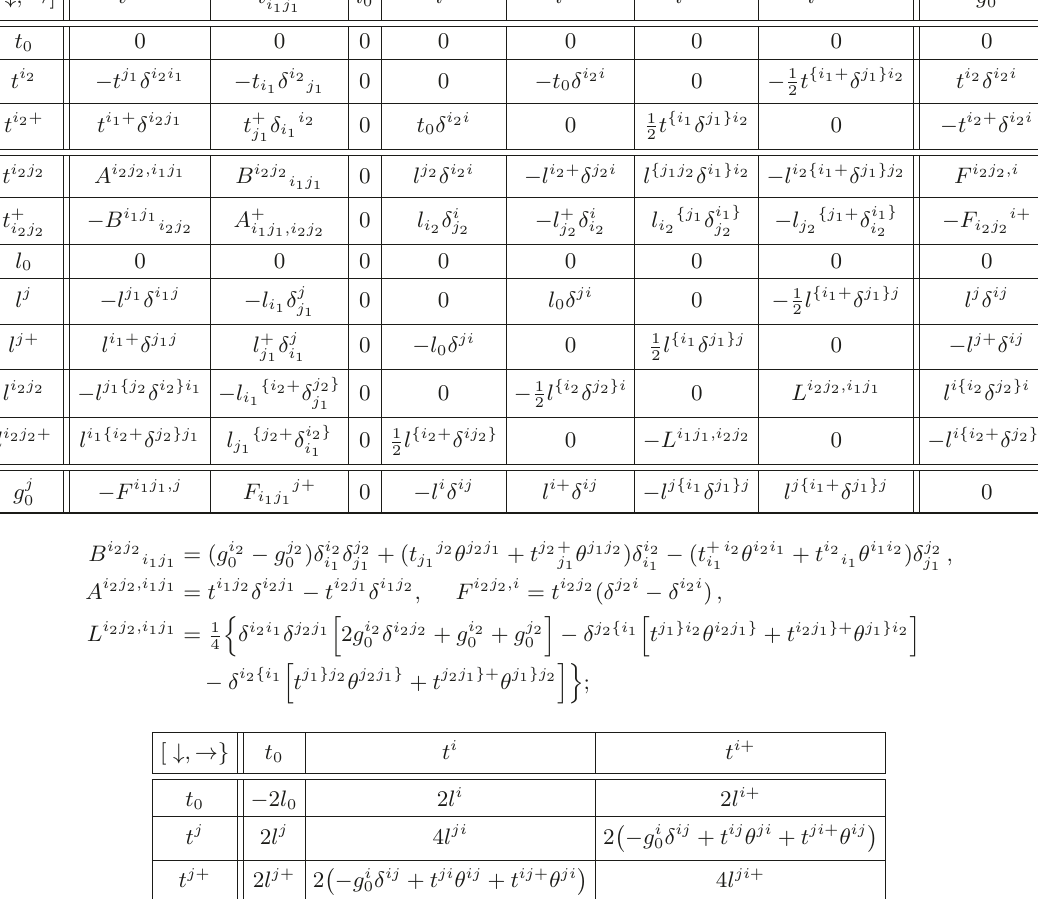
Table 1 . Even-even, odd-even and odd-odd parts of HS symmetry superalgebra